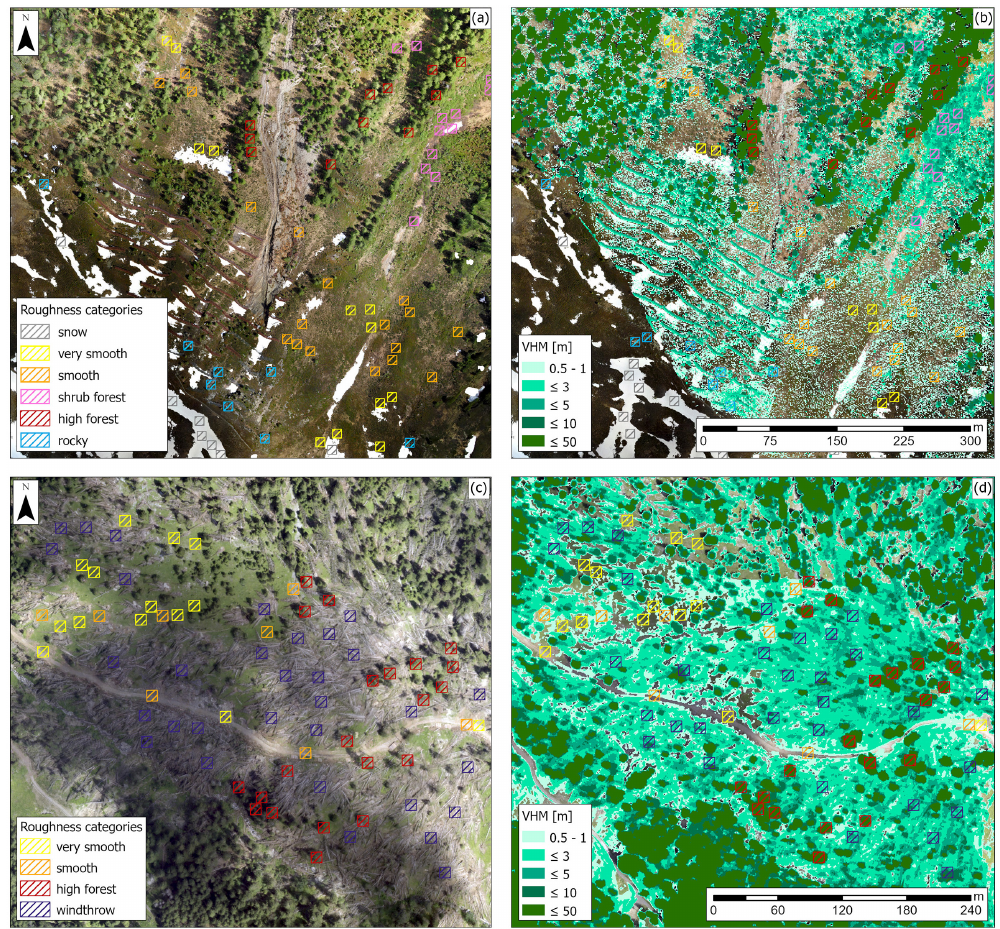
Figure 2. Roughness categories were selected based on the orthophoto alone (a) and (c) (drone flights, 2019) and with the vegetation height model (VHM, produced as the difference between the DSM and DTM provided by the Federal Office of Topography for Braema (© swisstopo, 2018) and Veneto region for Franza; b and d ). The Braema study area (Grisons, Switzerland) is shown in (a) and (b) , and the Franza study area (Veneto, Italy) is shown in (c) and (d)